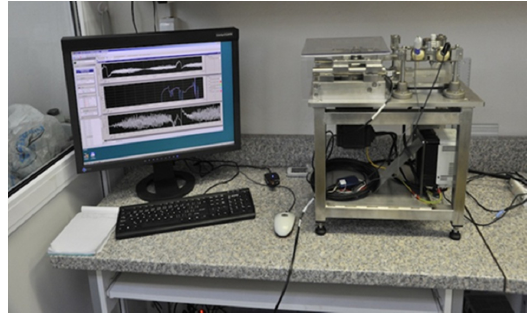
Figure 3. Prototype of a unique device for testing tribo-corrosive properties.